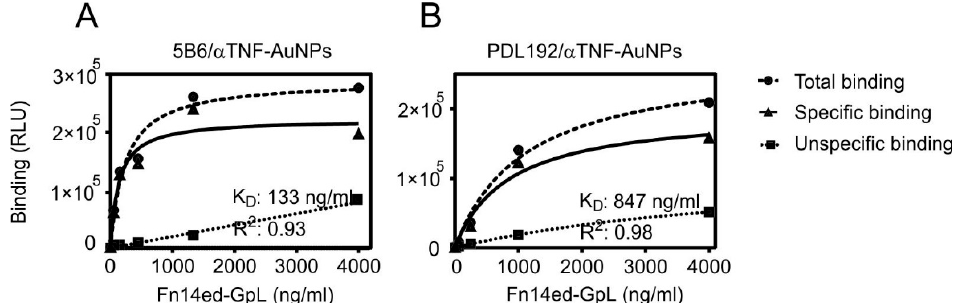
Figure 4. Specific binding of Fn14ed-GpL fusion protein to 5B6-AuNPs and PDL192-AuNPs. Three equal amounts of carboxyl-modified gold nanoparticles AuNPs (25 mg/mL) were conjugated with a constant concentration (2 mg/mL) of the anti-Fn14 antibodies 5B6 ( A ) and PDL192 ( B ) or anti-TNF as a negative control. After removal of unbound antibody molecules, the antibody-AuNP conjugates were incubated with the indicated concentrations of the Fn14ed-GpL fusion protein for an hour at 37 °C. After removal of the unbound Fn14ed-GpL molecules, nonspecific binding values were obtained from the anti-TNF-AuNPs and were subtracted from the corresponding total binding values obtained from the 5B6-AuNPs and PDL192-AuNPs to calculate the specific binding values. The latter were fitted using non-linear regression to a single binding site interaction plot using GraphPad Prism5 software.